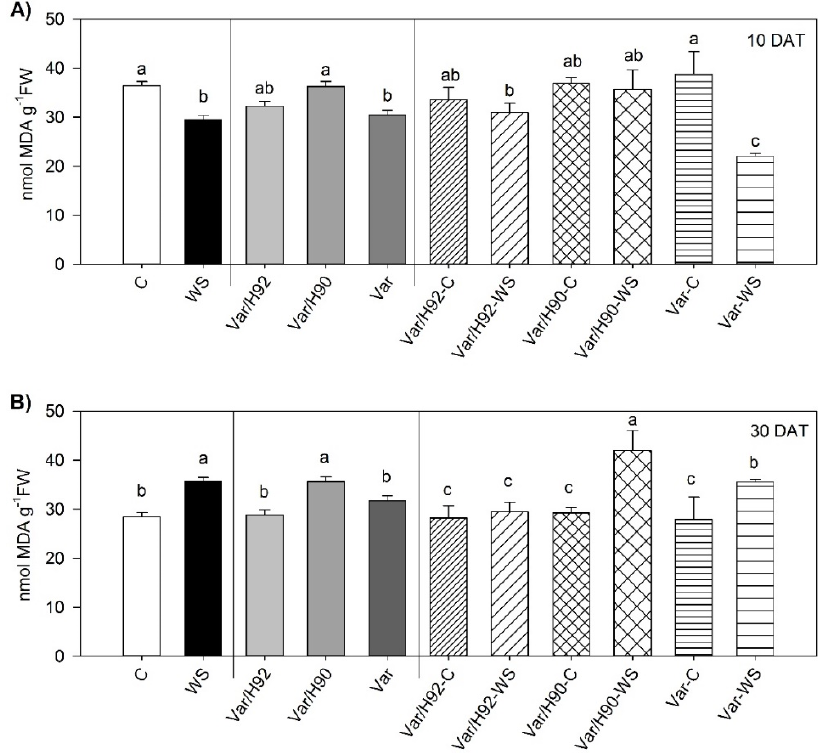
Figure 5. Lipid peroxidation (as malondialdehyde content, MDA) in the leaves of the ungrafted plants (Var, variety “Sueca”) and Var grafted onto H92 or H90 (Var/H92 and Var/H90) under the water stress (WS) or control conditions (C) at 10 ( A ) and 30 ( B ) days after treatment (DAT). Different letters indicate significant differences at p < 0.05 (LSD test) for each measurement time separately. Data are the mean of four replicates and the error bars belong to the standard deviation for each plant type and treatment combination.